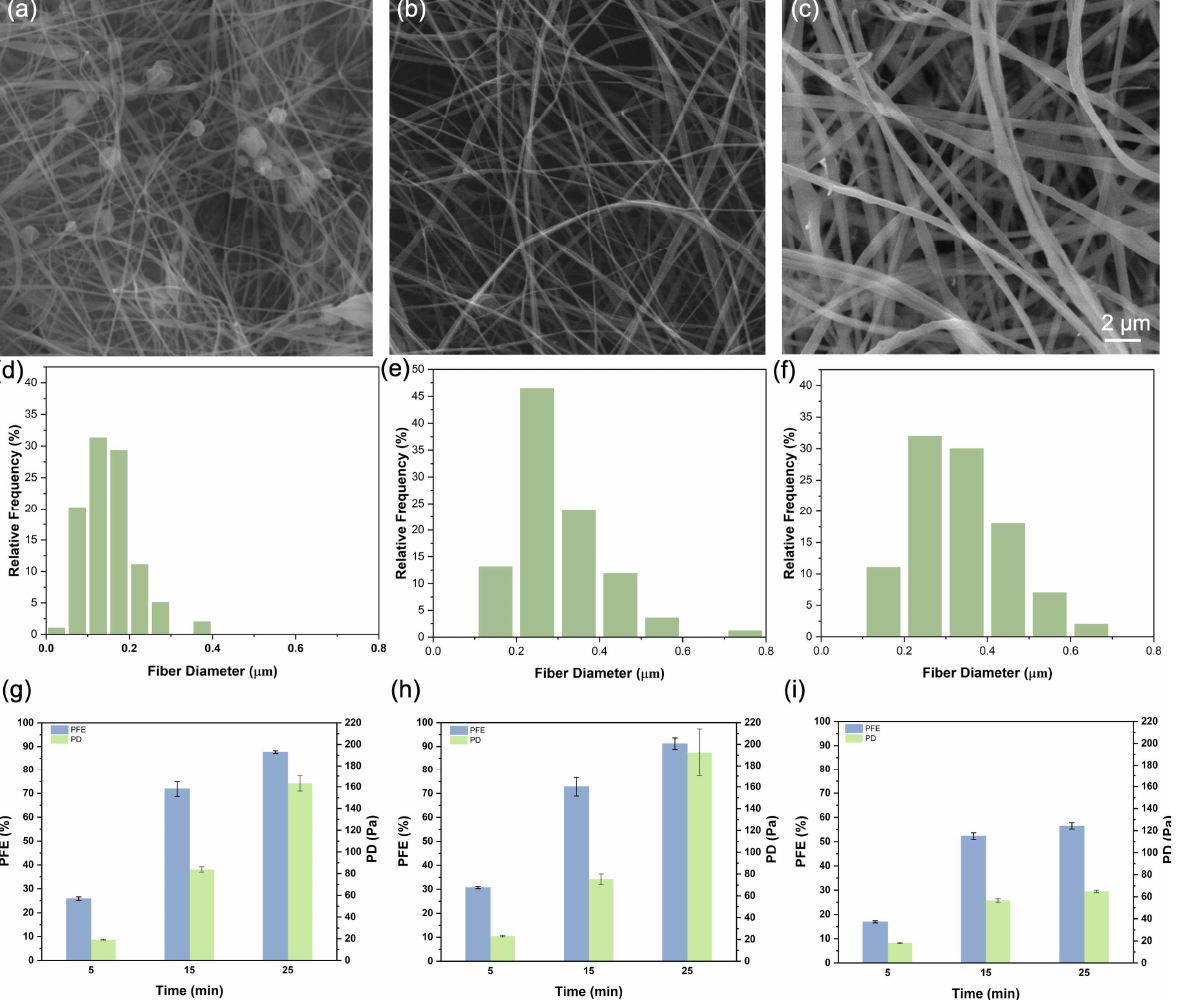
Figure 2. SEM of ( a ) 25%, ( b ) 30%, and ( c ) 40% fibers under a magnification of 8000 × and fiber diameters of ( d ) 25%, ( e ) 30%, and ( f ) 40% of crosslinked zein solution; air filtration including PFE and PD performance of ( g ) 25%, ( h ) 30%, and ( i ) 40% with three different electrospinning times from 5 to 25 min.